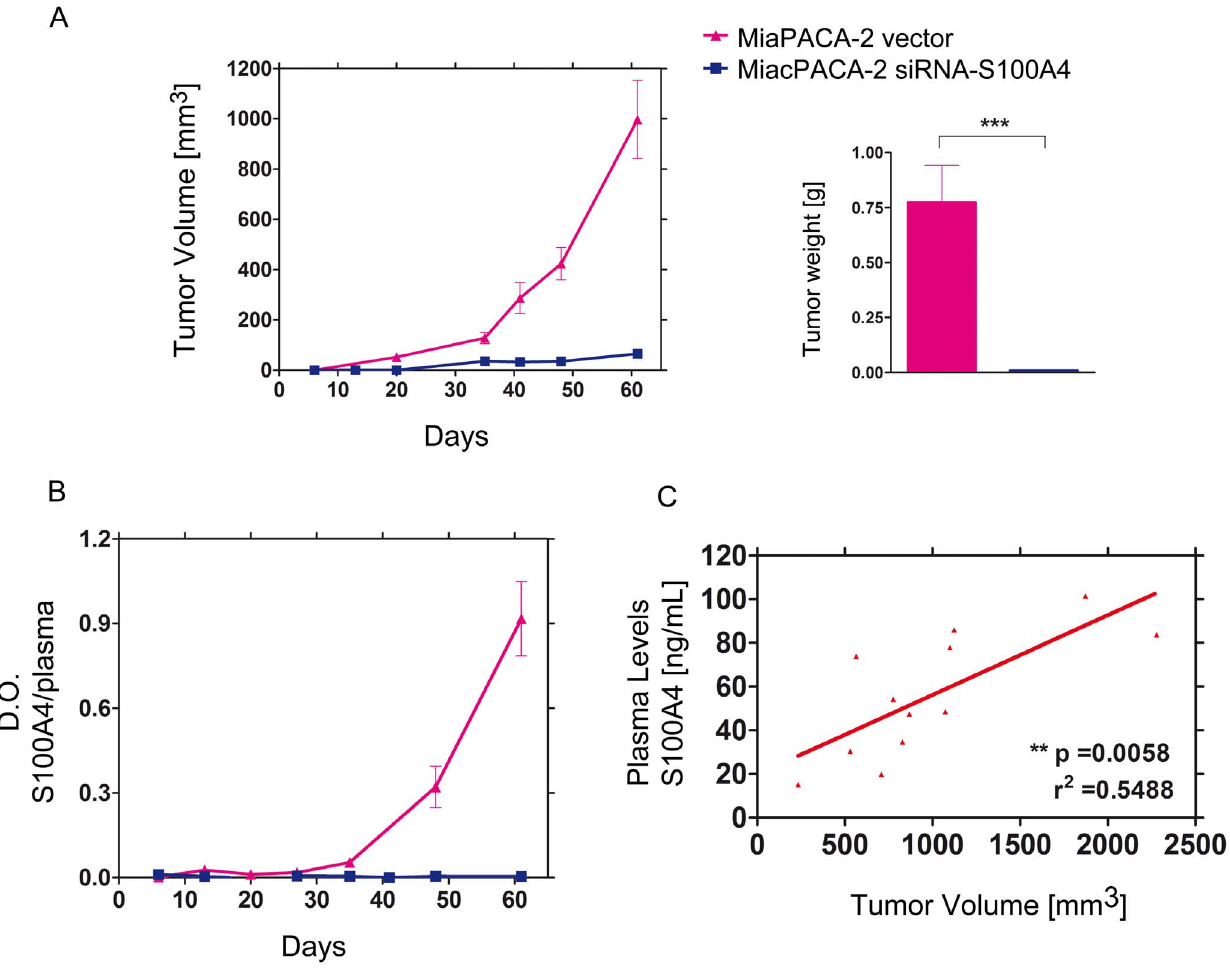
Figure 6. Tumorigenic study on MiaPACA-2 xenograft model silencing S100A4. A) Tumor growth of MiaPACA-2 transfected either with the pSilencer vector encoding for a shRNA against human S100A4 or for a non-related shRNA were compared. Groups had 15 animals. Graphs represent only animals that developed tumors. Bars of tumor weight show the mean 6 SEM. ***p , 0.001 . B) S100A4 plasma levels in MiaPACA-2 transfected with shRNA-S100A4 or with a non-related shRNA were measured once a week. C) Correlation between plasma levels of S100A4 protein and tumor burden. Graphs of plasma levels show the mean 6 SEM. **p , 0.01 . r 2 represents the coefficient of determination.